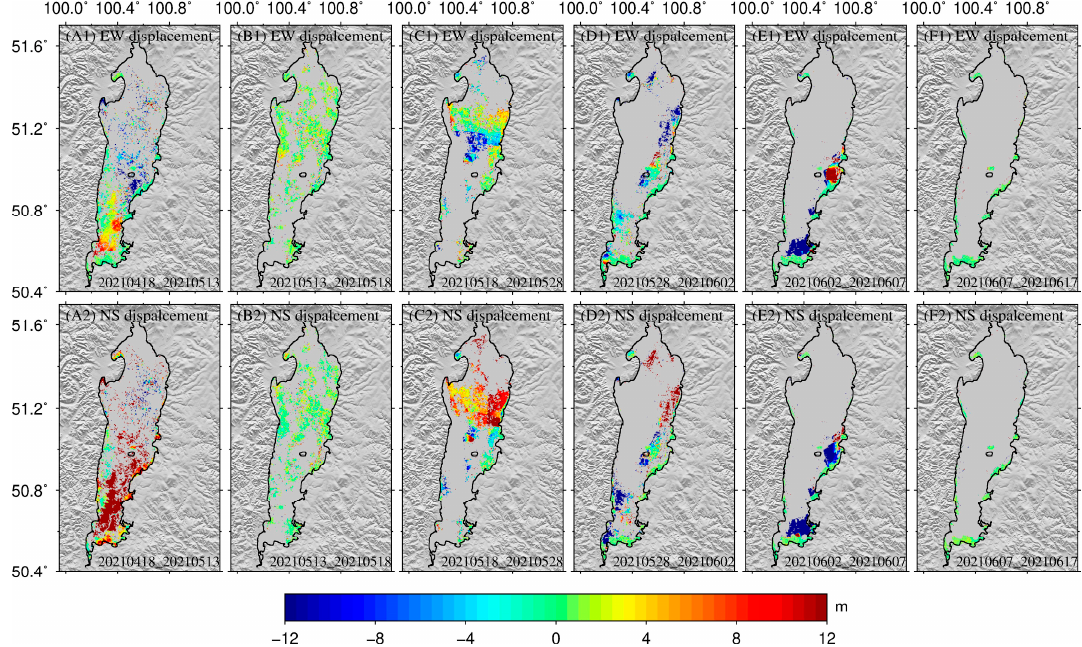
Figure 7. ( A1 – F2 ) represent the results of horizontal displacement of Lake Khovsgol in the EW and NS directions in the third stage. It is superimposed on 3 Arc-Second Global SRTM Digital Elevation Model (DEM) with 90 m resolution. The graphs are basically anomalous values. The displacement values in the EW and NS directions are positive.